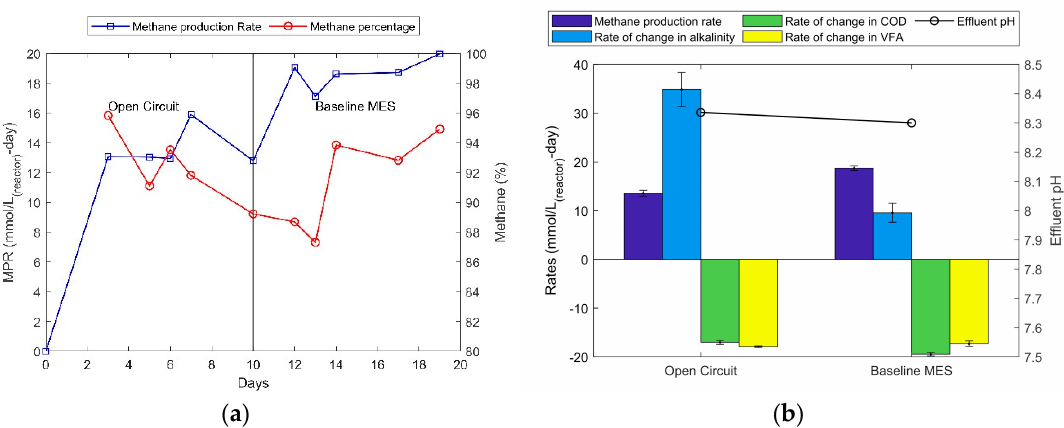
Figure 3. ( a ) Methane production rates in open circuit and baseline MES operations. ( b ) Yields of different parameters in open circuit and MES operating mode.